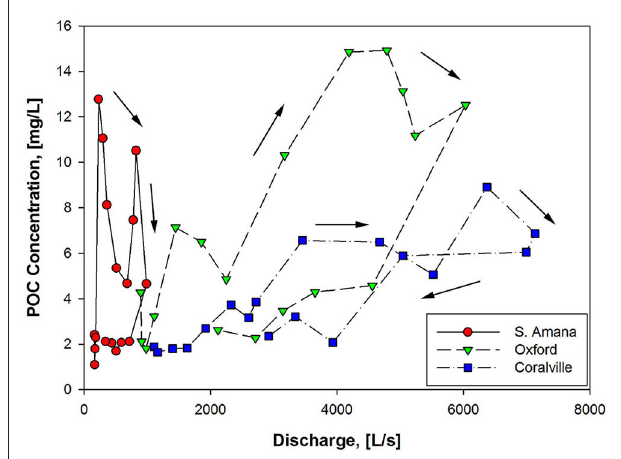
FIGURE 5 | POC concentrations as a function of